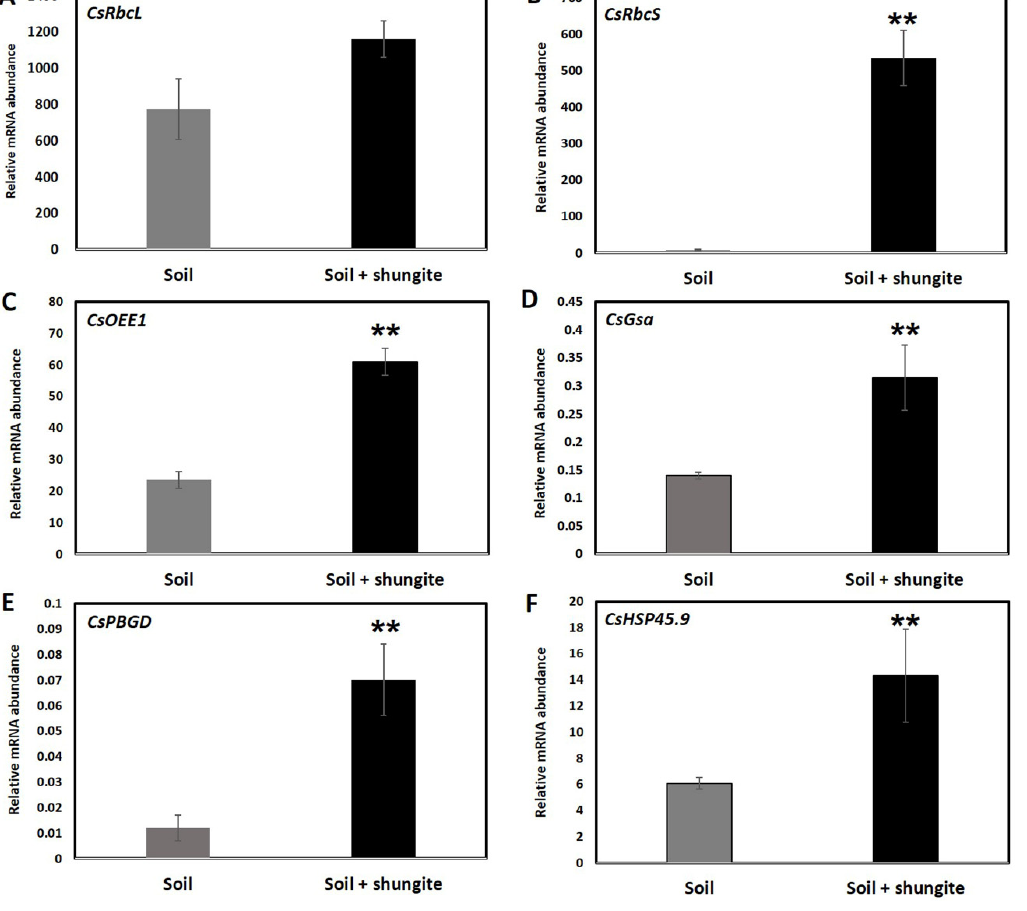
Figure 3. Effects of shungite and/or heat stress treatment on CsRbcL , CsRbcS , CsOEE1 , CsGsa , CsPBGD , and CsHSP45.9 transcripts in leaves of cucumber were determined using real-time PCR ( A – F ). The γ -axis represents relative expression levels normalized by the elongation factor 1-alpha ( CsEF1 α ) gene ( Csa006172 ). Three independent experiments with three biological replicates were averaged (± SD). Statistically significant differences between control and shungite-treated groups at corresponding time points are indicated by asterisks (Student’s t -test, ** p ≤ 0.05).